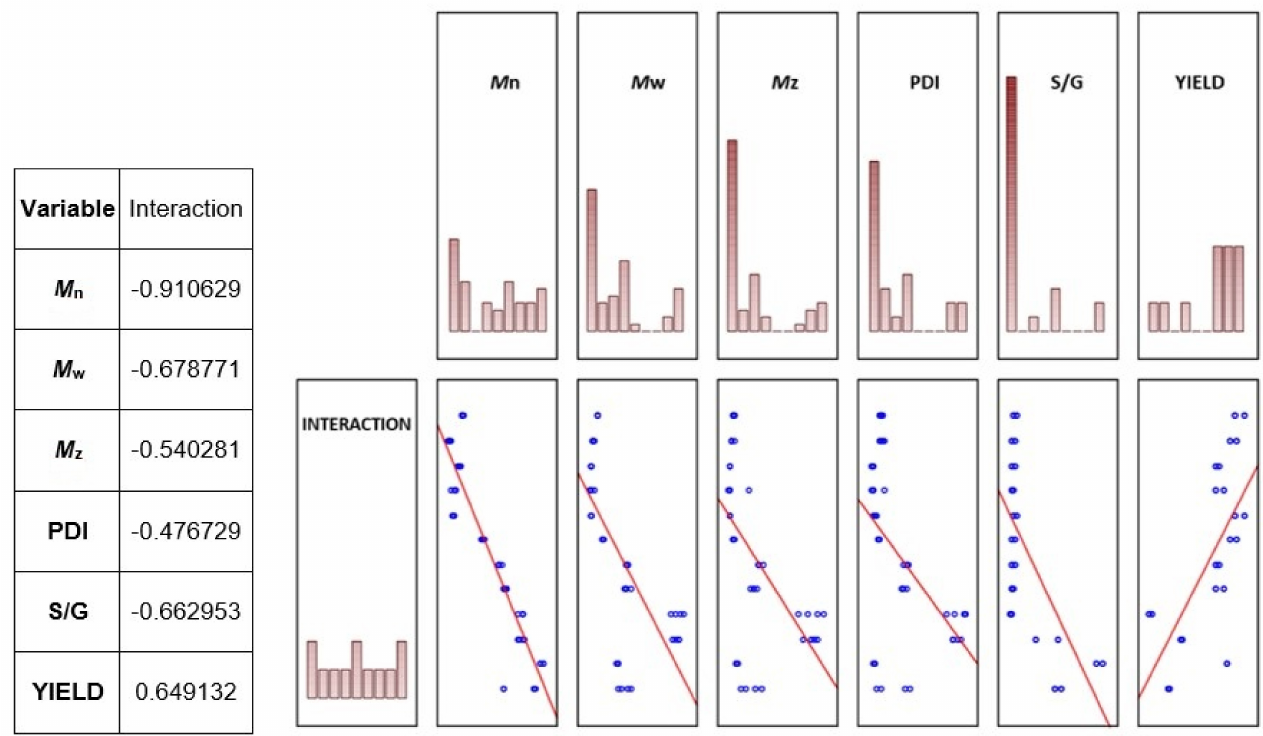
Figure 13. Correlations of the interaction of thermal modification temperature and wood species with the values of the mon- itored characteristics M n , M w , M z , S/G, and YIELD evaluating the mutual connection between the monitored